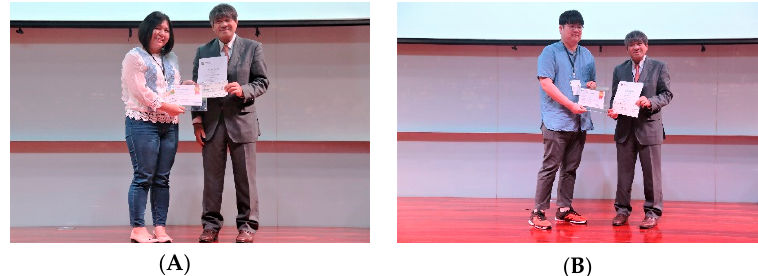
Figure 2. Kotohiro Nomura presented the poster presentation awards to Siraphat Putisompon ( A ) and Hanbyul Kim ( B ).